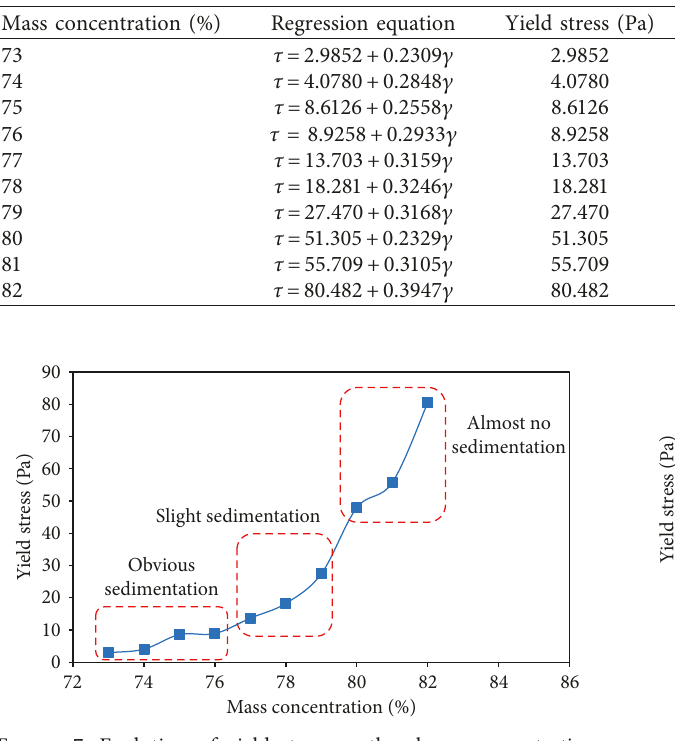
Figure 7: Evolution of yield stress as the slurry concentration increases. Figure 8: Simultaneous evolution of settling ratio and yield stress at various mass concentrations.